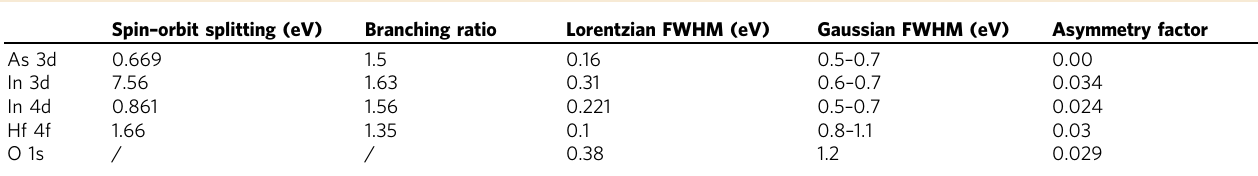
Table 1 XPS fi t